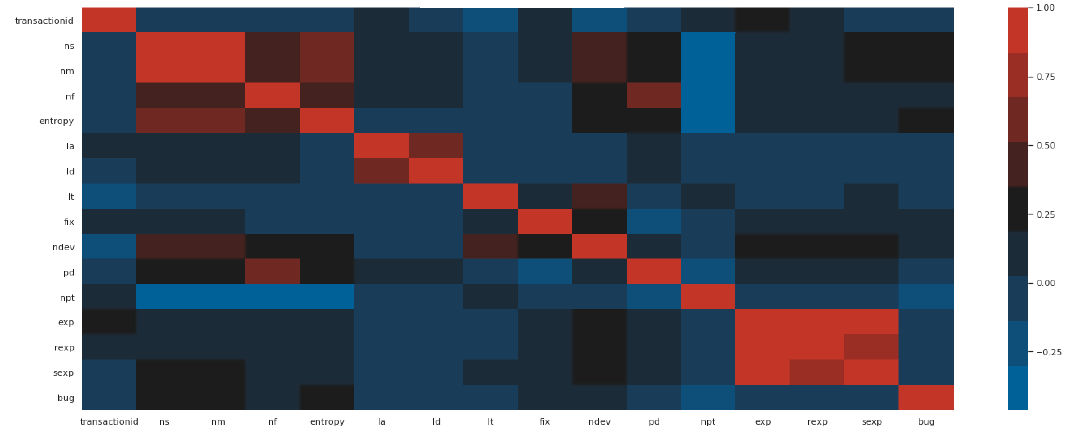
Figure 3. Imbalance correlation matrix of attributes.